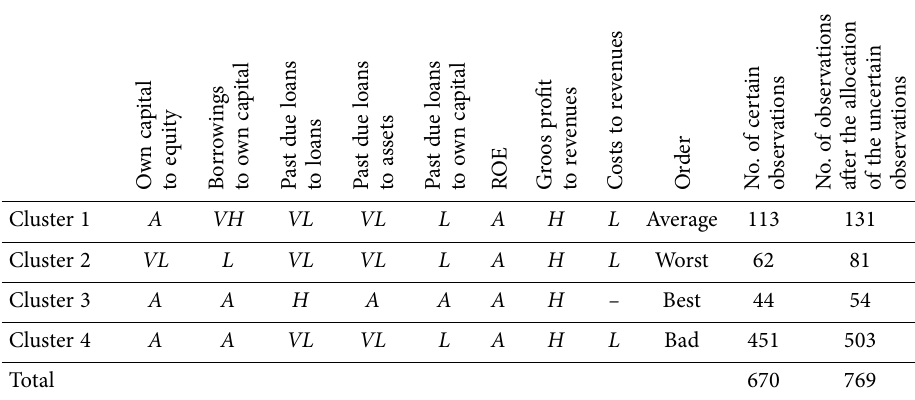
Table 3. Characterization of